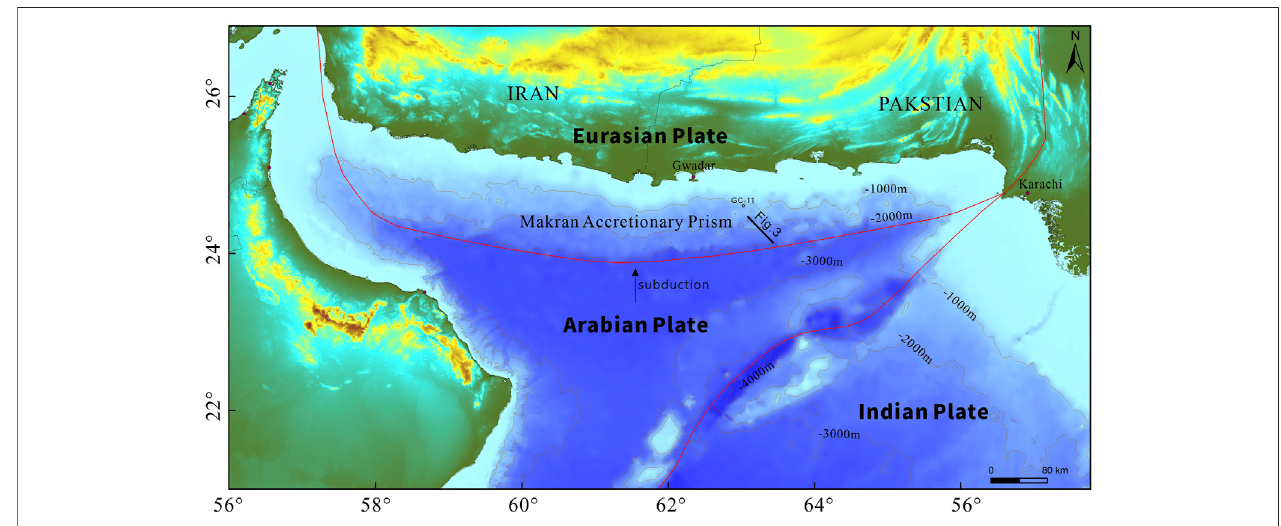
FIGURE 1 | Locations of the study area and seismic pro fi le.